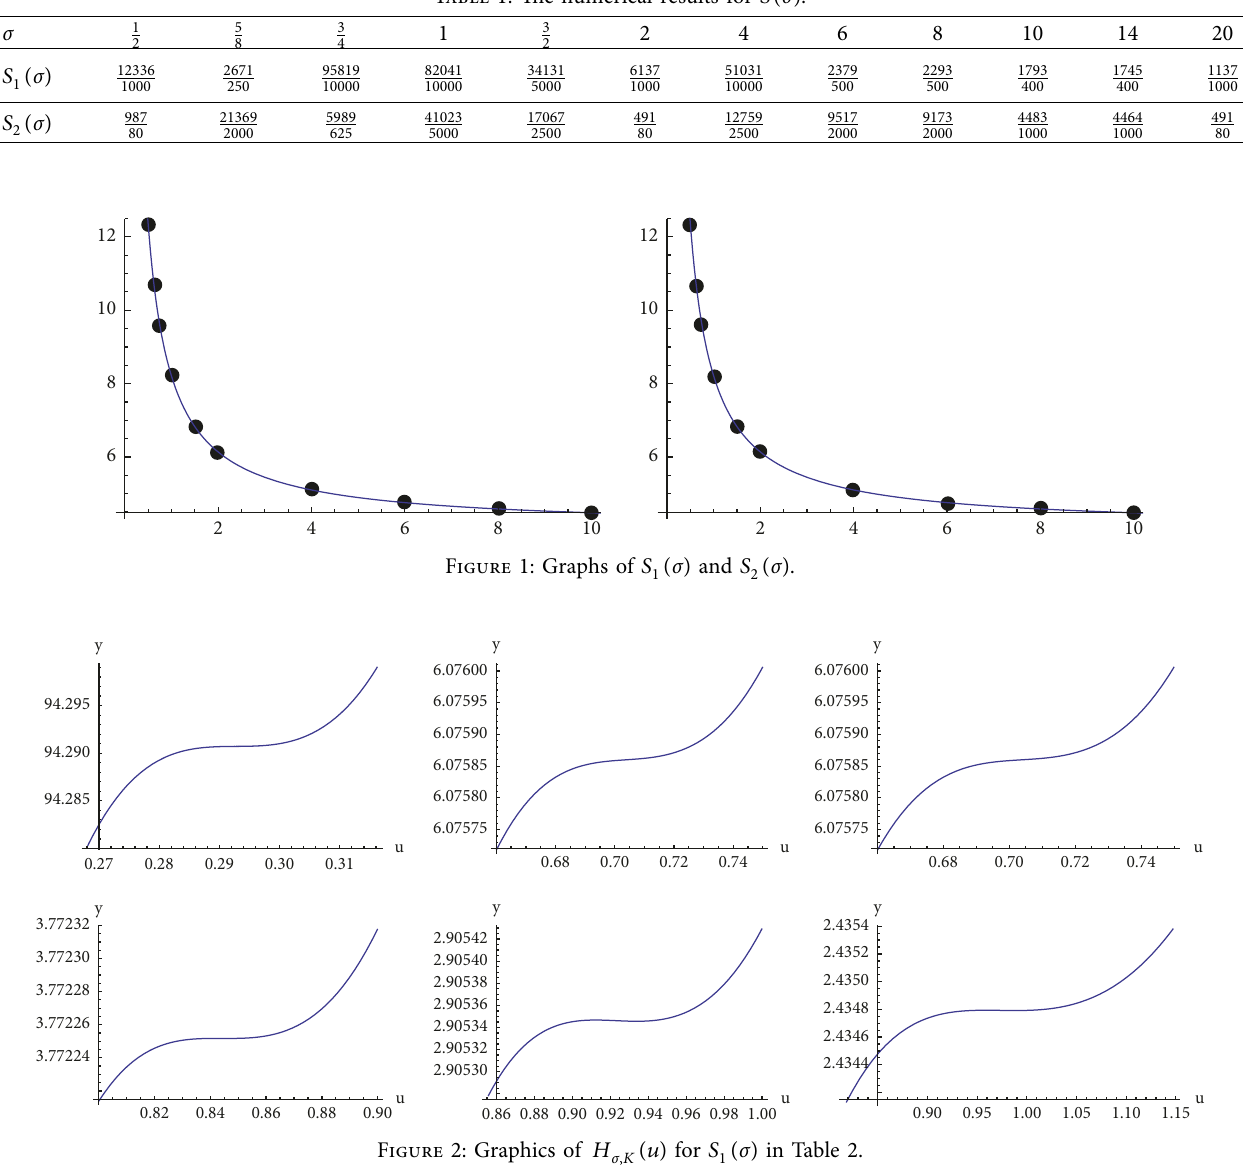
Table 1: The numerical results for S ( σ ) .